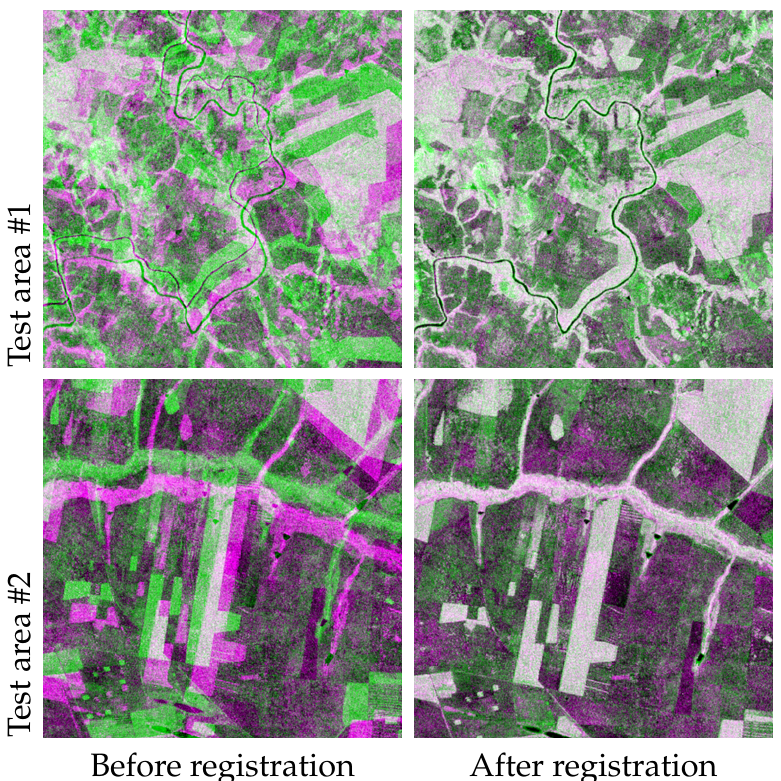
Figure 8. Results of the proposed multisensor registration method applied to the Brazil dataset: false-color overlay of the real and estimated SAR images (G = reference; R = B =